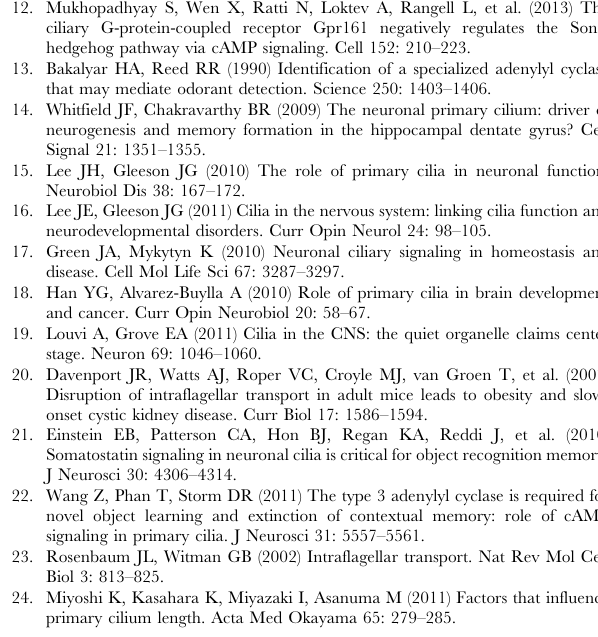
Figure S2 Nigrostriatal dopaminergic lesions did not affect the length of primary cilia of striatal astrocytes in rats. (A) An immunofluorescence analysis of astrocytic cilia in the dorsolateral striatum from the unilaterally nigrostriatal-lesioned rat that was fixed on day 28. Primary cilia stained with an antibody to Arl13b (green) protruded from S100 b -positive astrocytic cell bodies (red) on the contralateral (contra) and ipsilateral (ipsi) sides. Arrows =primary cilia; scale bars = 10 m m. (B) The average length of at least 200 astrocytic cilia on both sides of the striatum from each of four unilaterally-lesioned rats on day 28 and of four sham- operated (Sham ope) rats on day 28 was calculated. The data are means 6 SEM of four average values per group. There was no significant difference in the length of astrocytic cilia between the contralateral and ipsilateral sides of the striatum in the 6-OHDA- lesioned rats and in the sham-operated